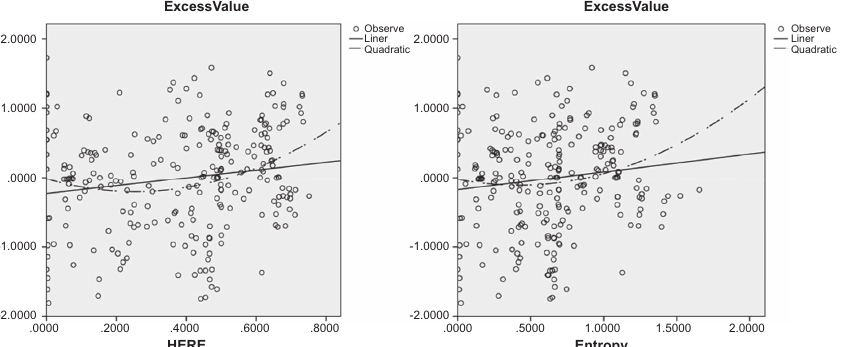
Figure 1. Plot of nonlinear relationship between diversification (Herfindahl and total entropy index) and excess